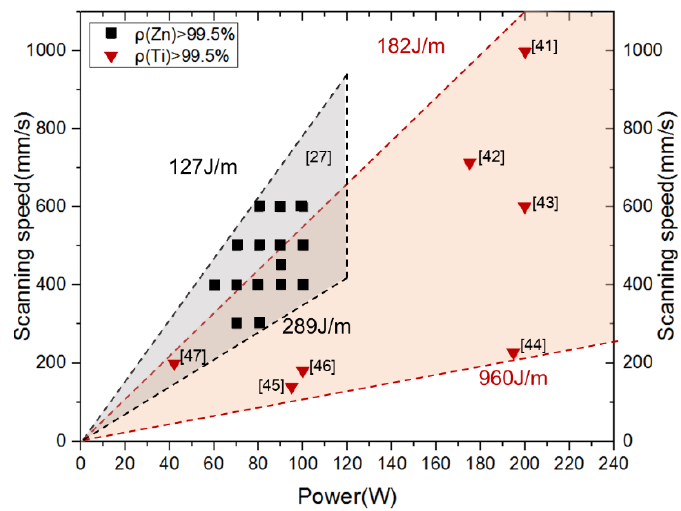
Figure 12. Processing windows of pure Zn and TC4 produced by the LPBF.